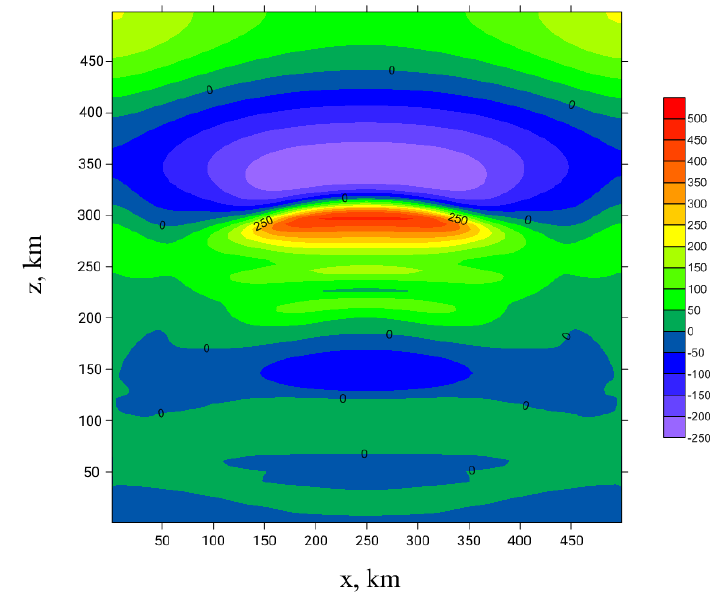
Figure 1. Wave perturbation of temperature from a local source of pressure fluctuations for the considered moment of time. Courtesy of. Yu. Kurdyaeva (see